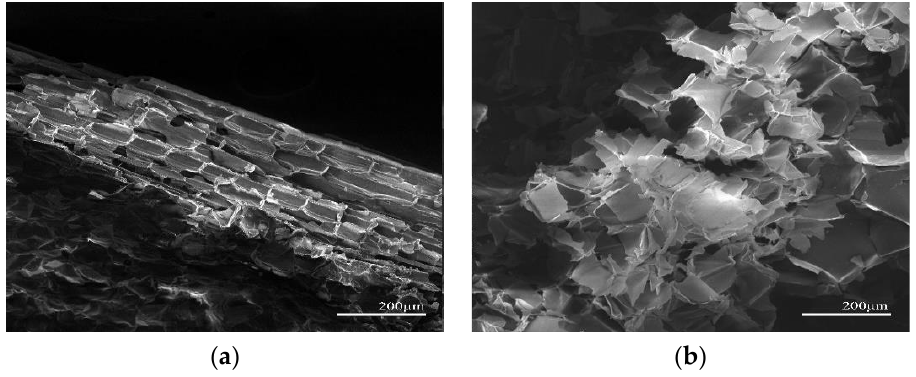
Figure 7. Microstructure of corn straw treated with siliceous solution: ( a ) vertical section of corn straw, ( b ) vertical section of corn straw core.